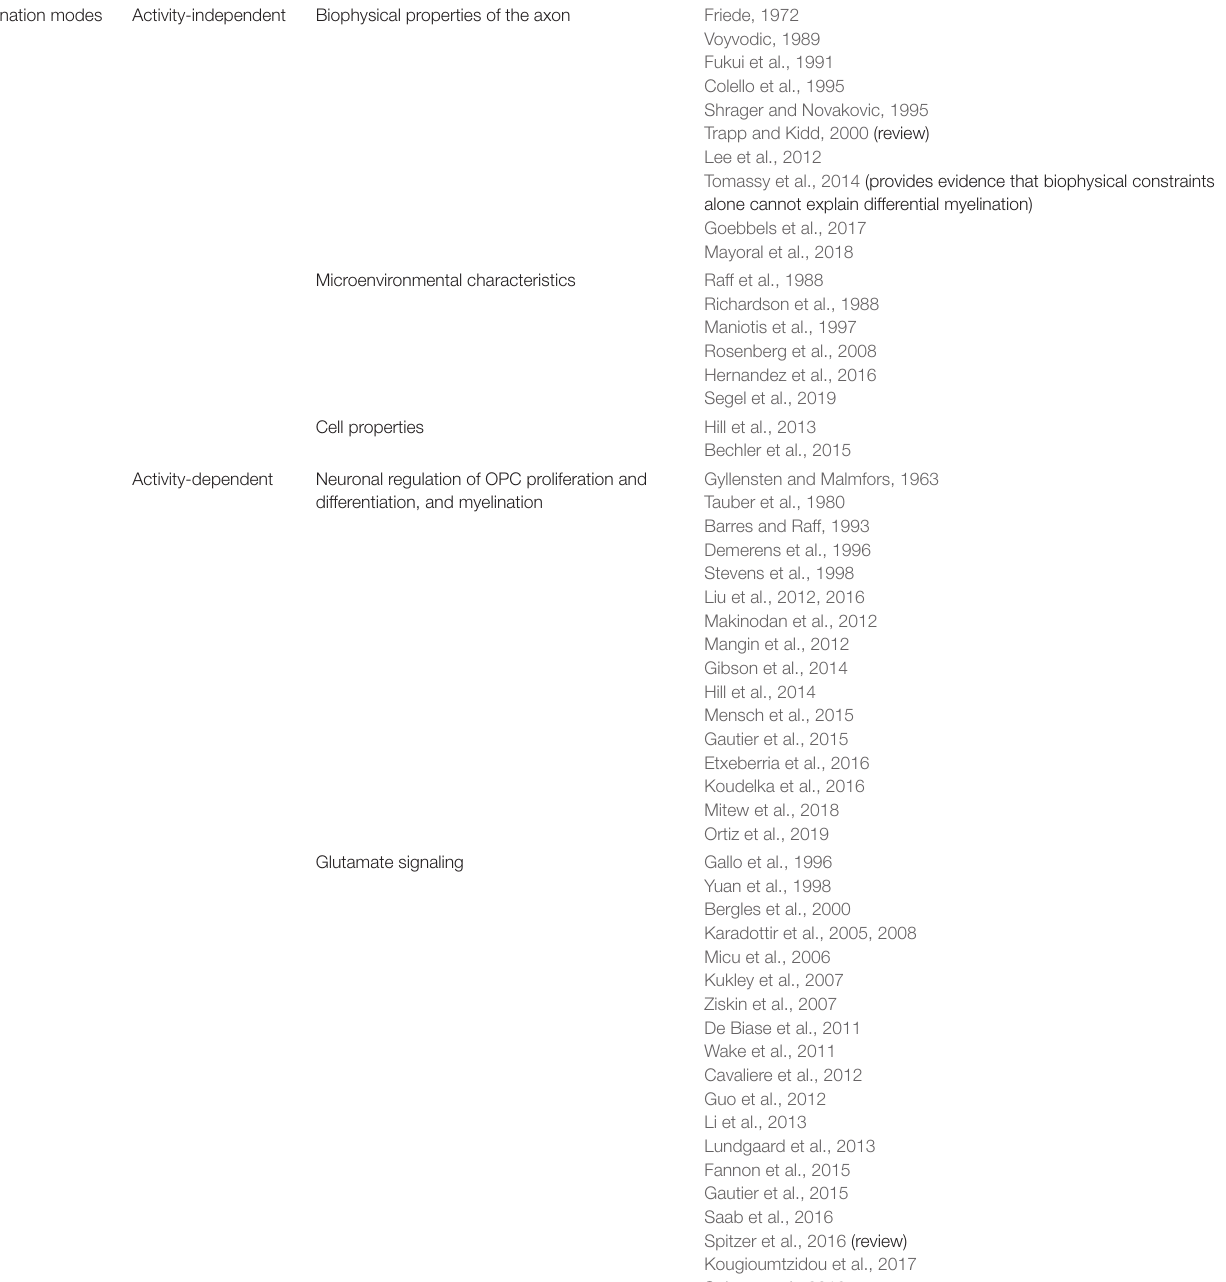
TABLE 1 | Summary of current literature on activity-independent and activity-dependent myelination in the